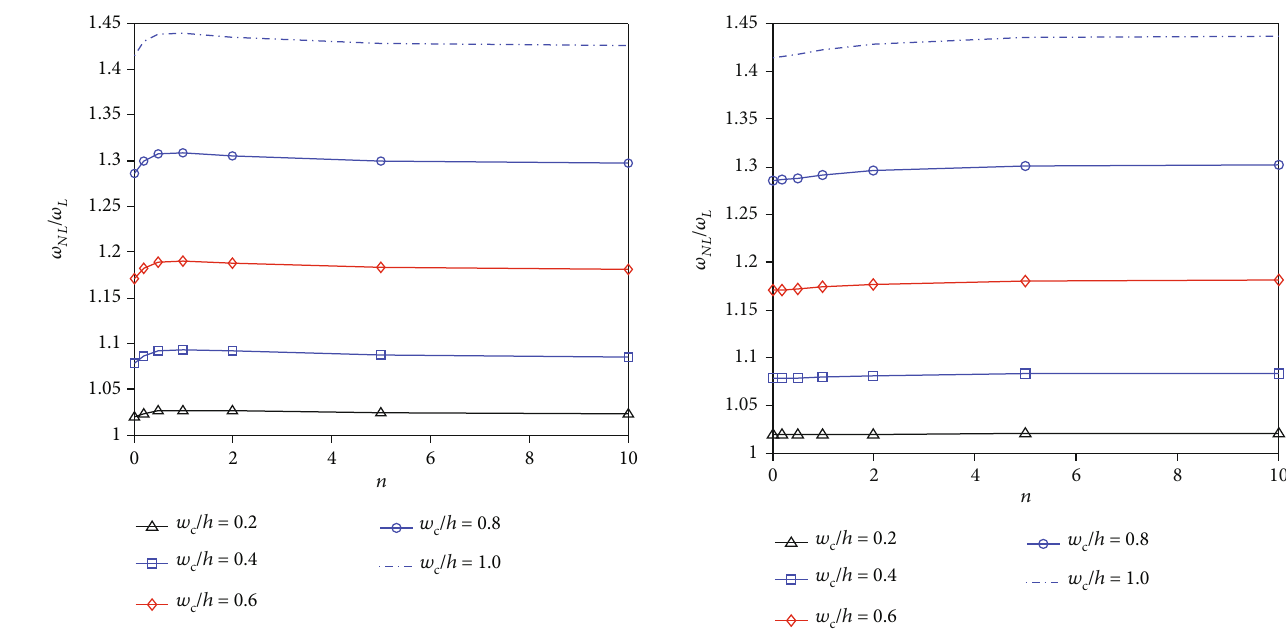
Figure 10: E ff ect of volume fraction index n , q = 10 , a / h = 10 ,